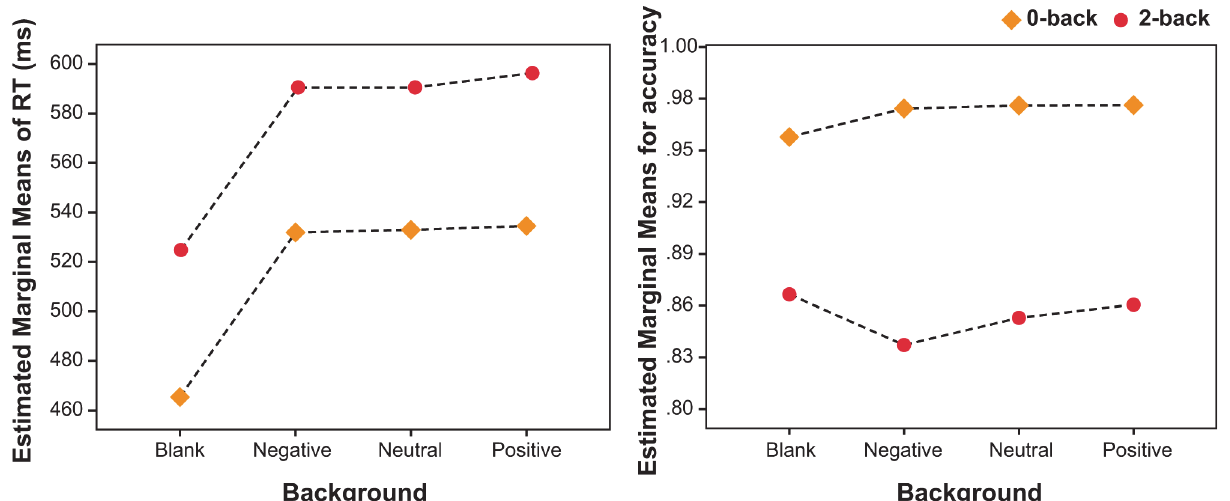
Fig 5. Estimated marginal means of correct-trial reaction time and of accuracy, for the EM- n -back conditions.